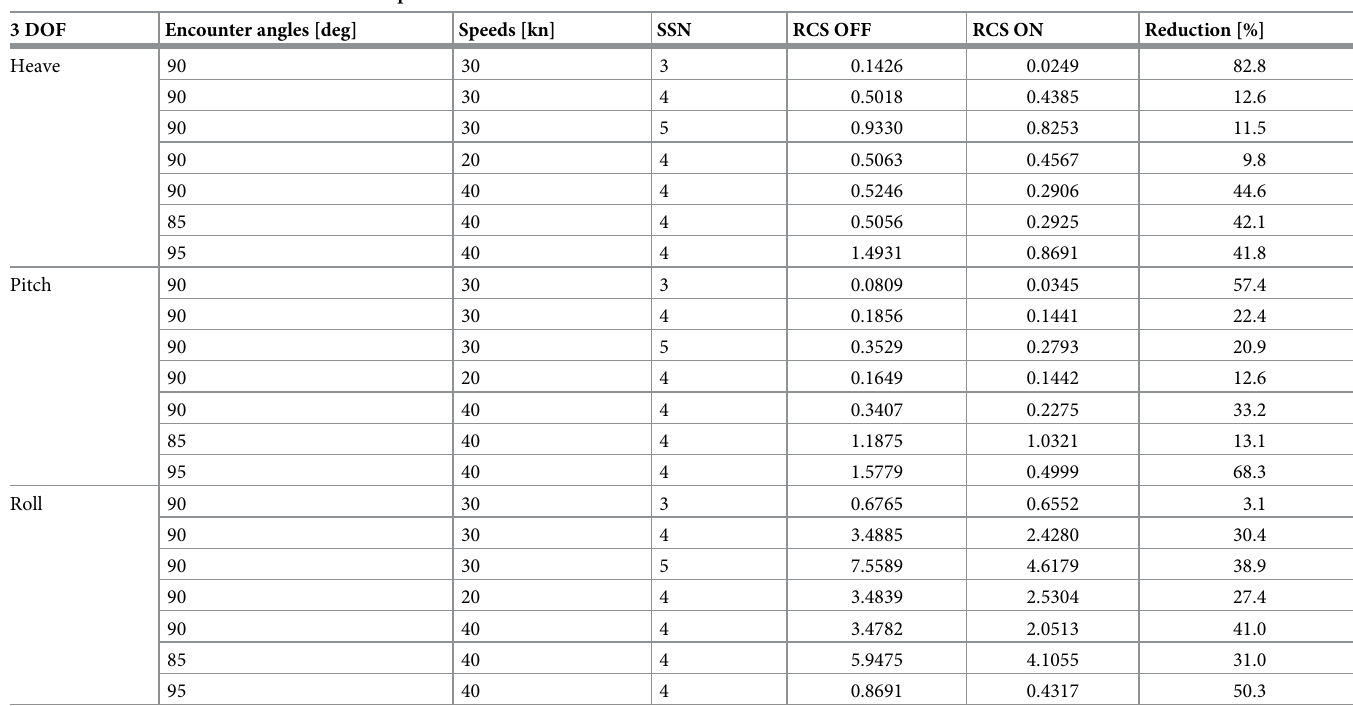
Table 4. Anti-3 DOF motion effect with two